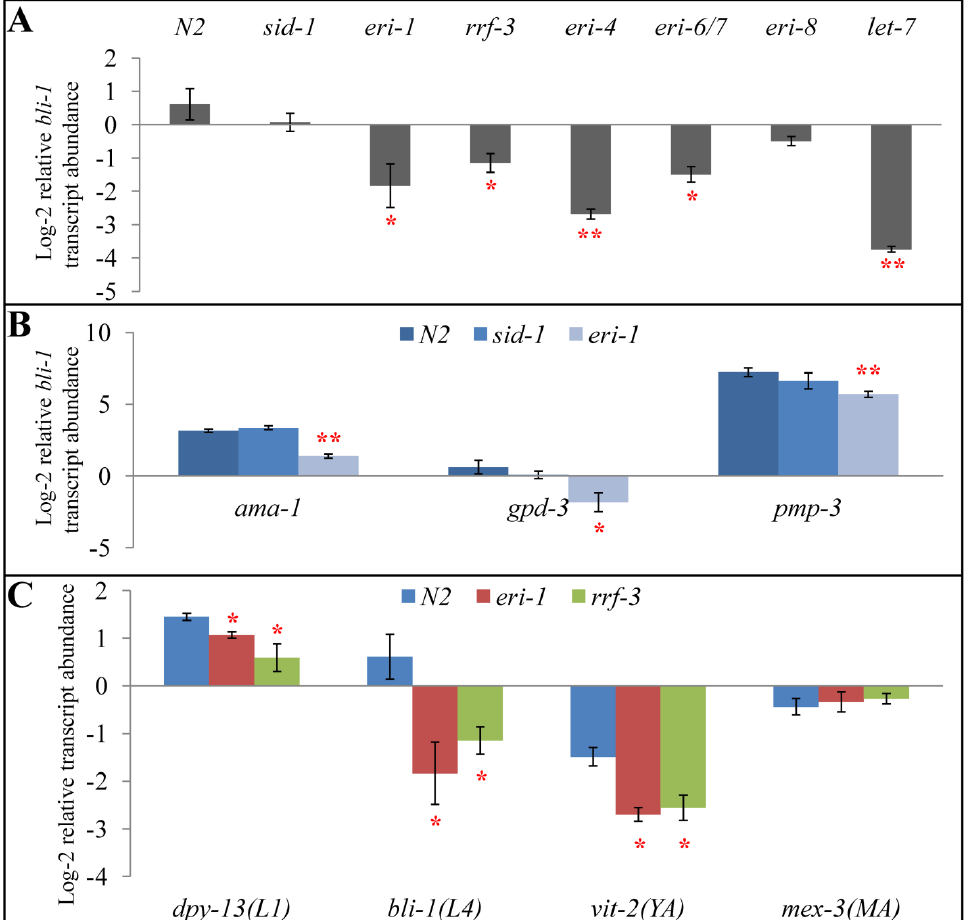
Figure 3. Abundance of developmentally regulated transcripts in endo-RNAi mutants. (A) gpd-3 normalized bli-1 transcript abundance at mid-L4 (69 hours post hatching